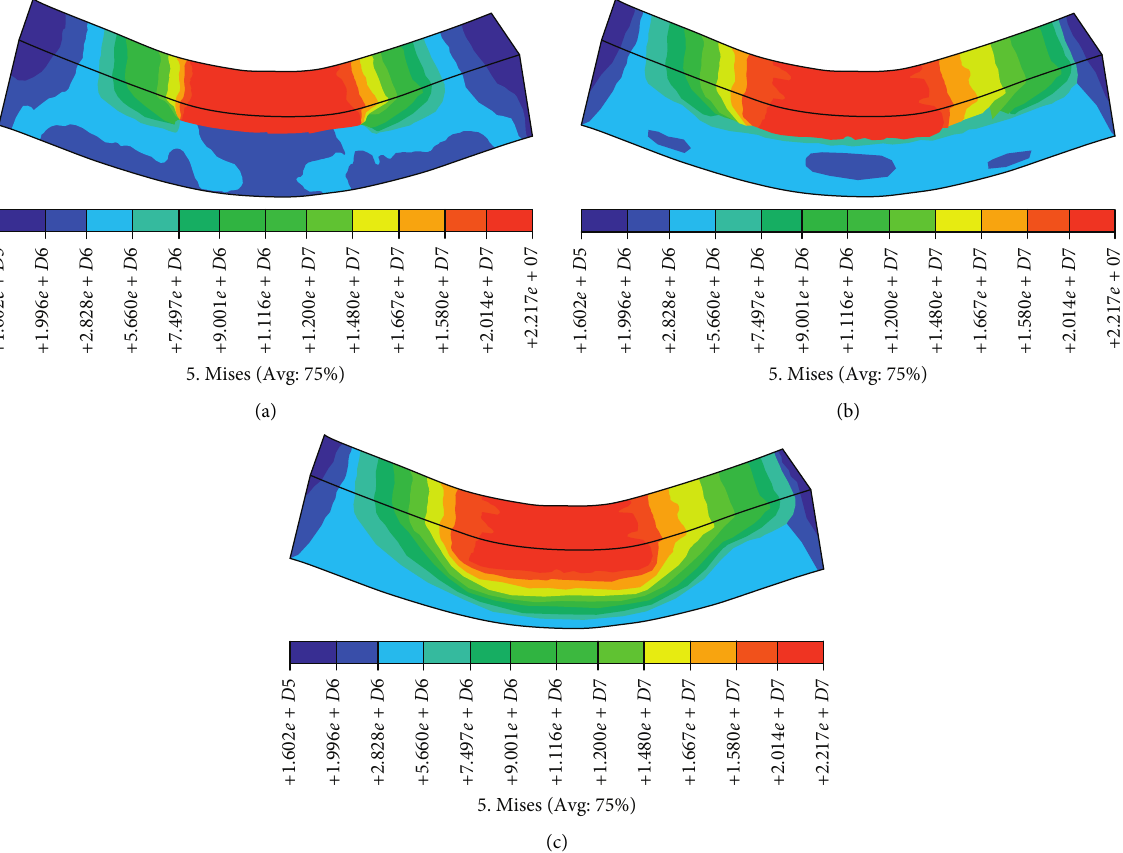
Figure 3: 3D finite element numerical simulation results of rheological casting processing of metal material. (a) Load � 2kPa. (b) Load � 3 kPa. (c) Load �